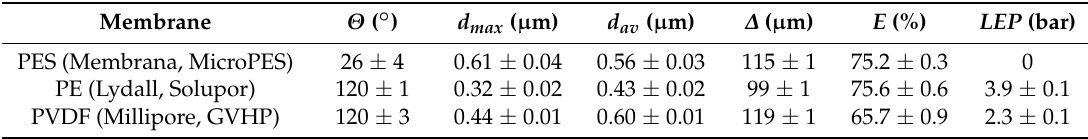
Table 2. Characteristics of the hydrophilic support membrane (polyethersulfone (PES)) and the membranes commonly used for membrane distillation (polyethylene (PE) and polyvinylidene fluoride (PVDF)).